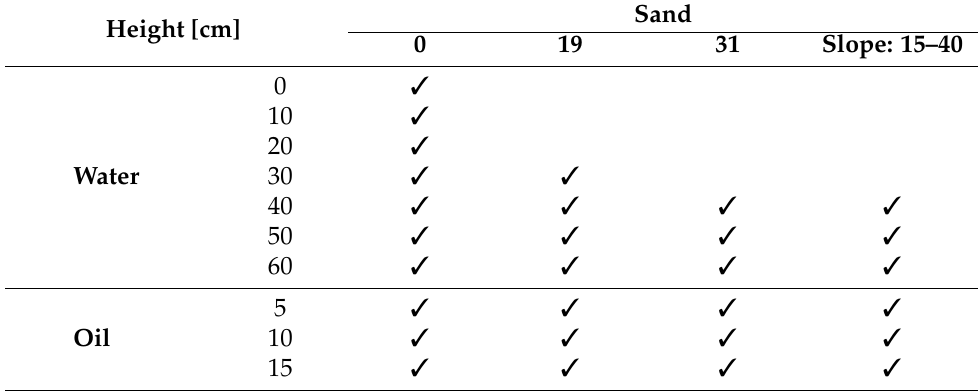
Table 2. Measured filling state combinations marked by (cid:51) . Note that the heights of the oil phases are related to the 60cm water filling, while the water height is giving the top-level even in the presence of a sand